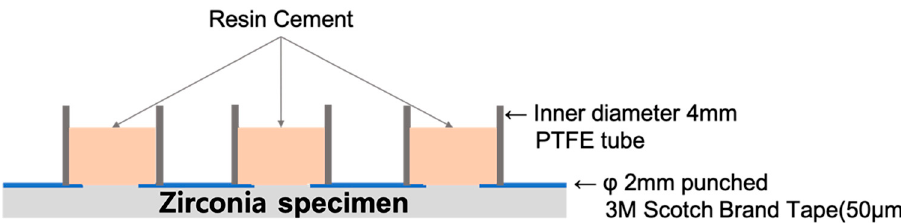
Figure 3. Schematic illustration of making the shear bond strength